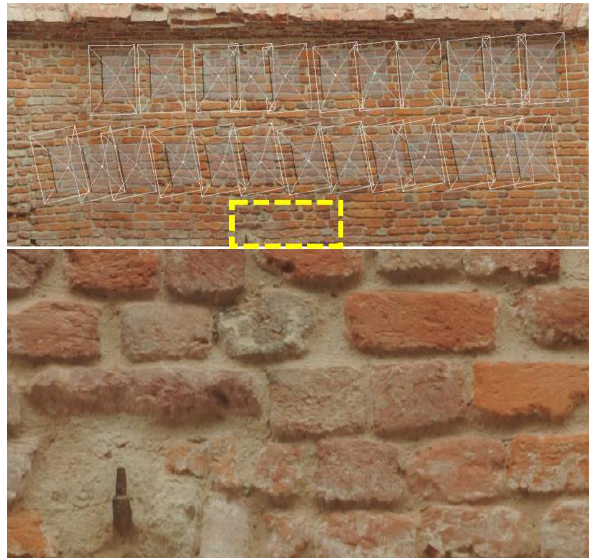
Figure 9. Results with an additional strip allow one to generate a better textured model / orthophoto.